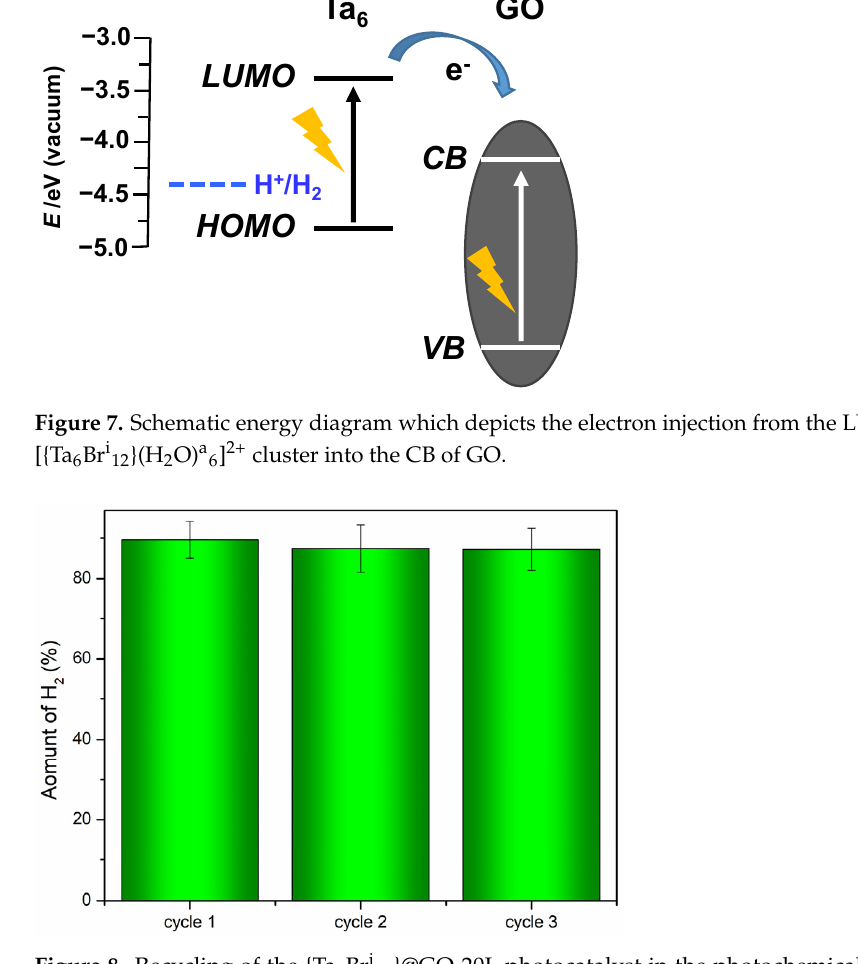
Figure 8. Recycling of the {Ta 6 Br i 12 }@GO-20L photocatalyst in the photochemical H 2 production from water/methanol/HBr in vapor phase after 24 h of irradiation.